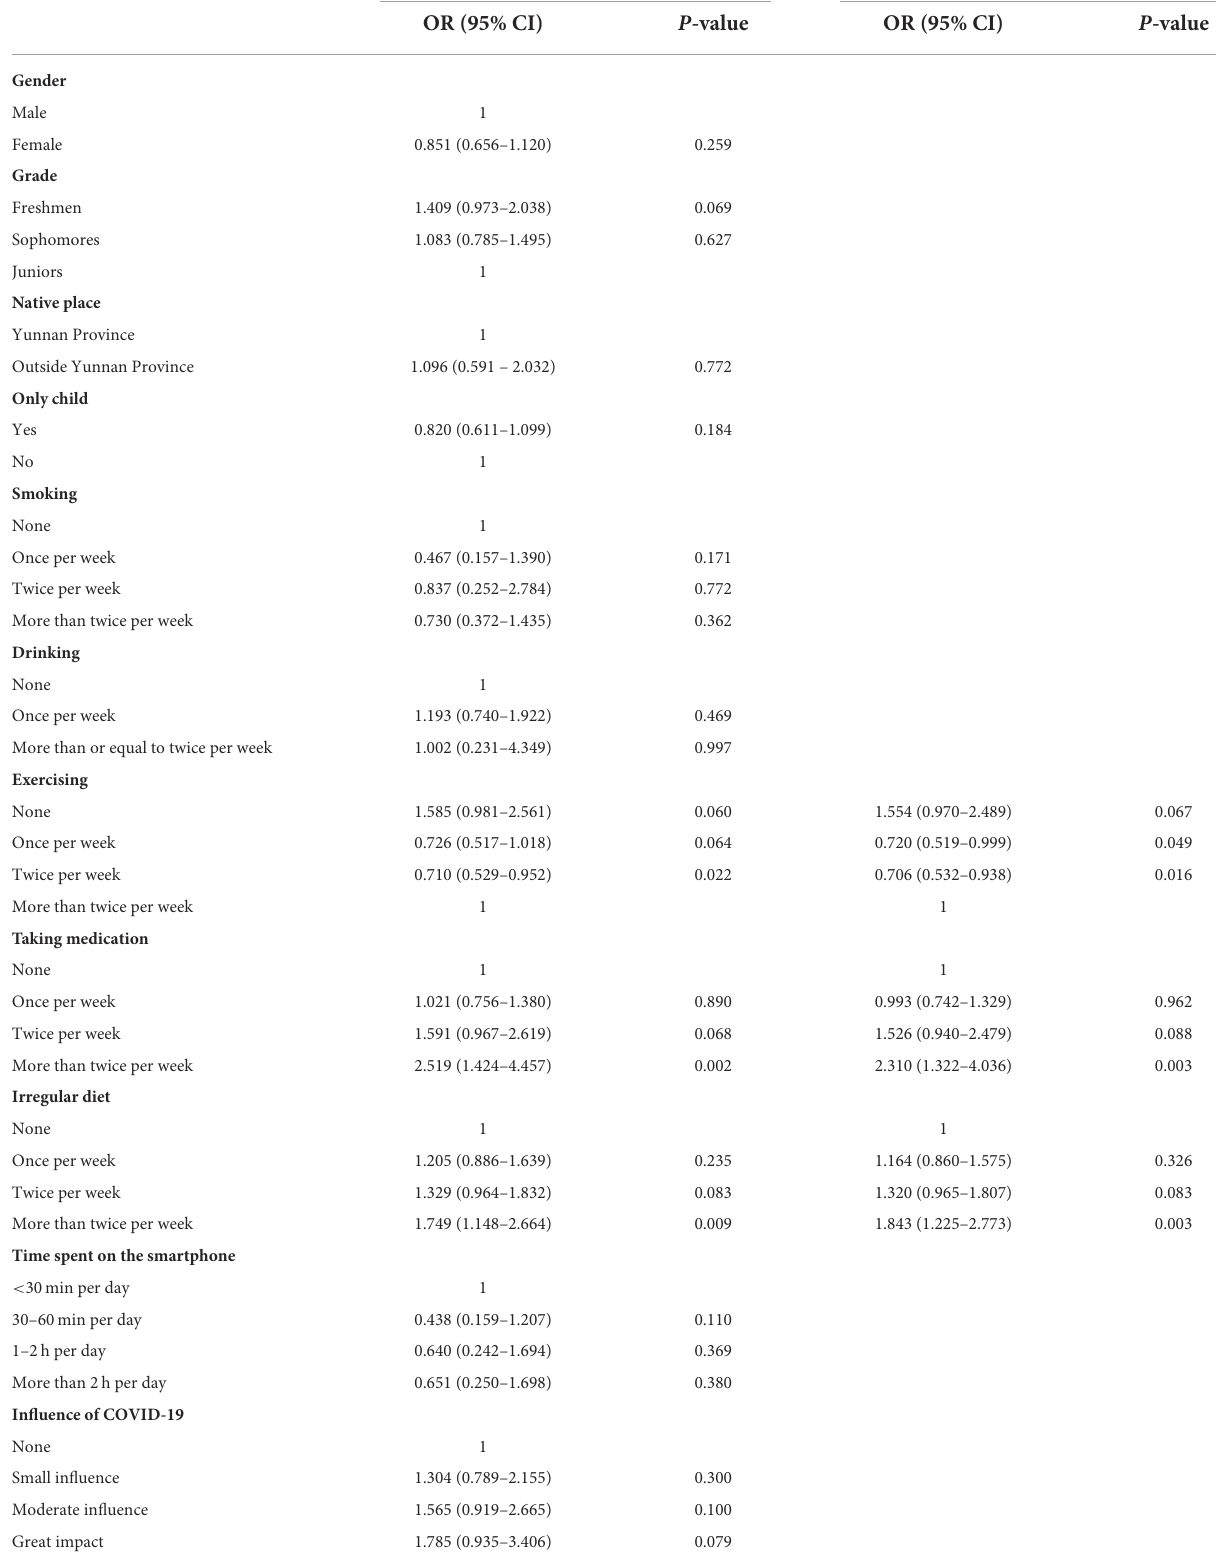
TABLE 4 Logistic regression analysis for risk factors of